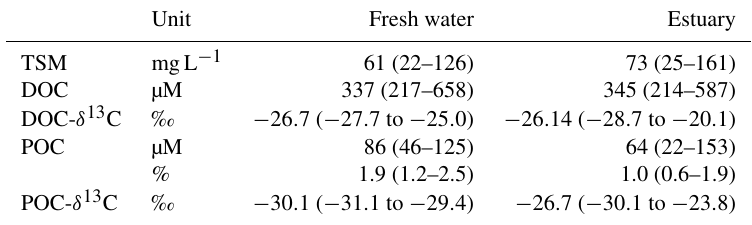
Table 1. TSM, DOC, POC, and stable carbon isotopes in the fresh water and estuary of the Rajang (mean (min–max)).